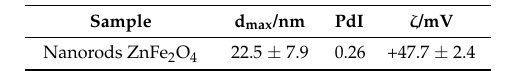
Table 1. The hydrodynamic diameters and zeta potentials of ZnFe 2 O 4 nanorods.